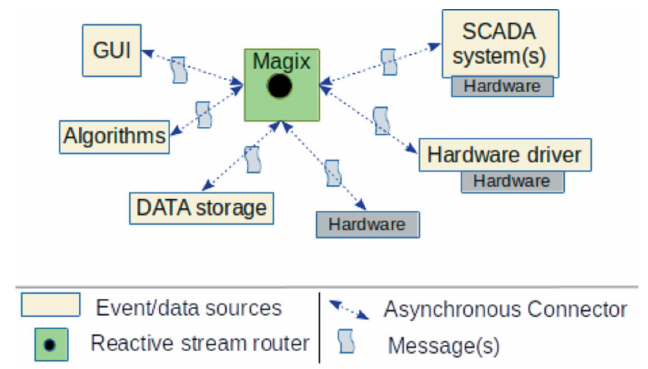
Figure 3 Overview of the interconnection platform. Here Magix is a core component responsible for the message flow between components. Each software component, shown as yellow boxes, deals only with incoming messages without knowing any details of the counterparty component. All communication is